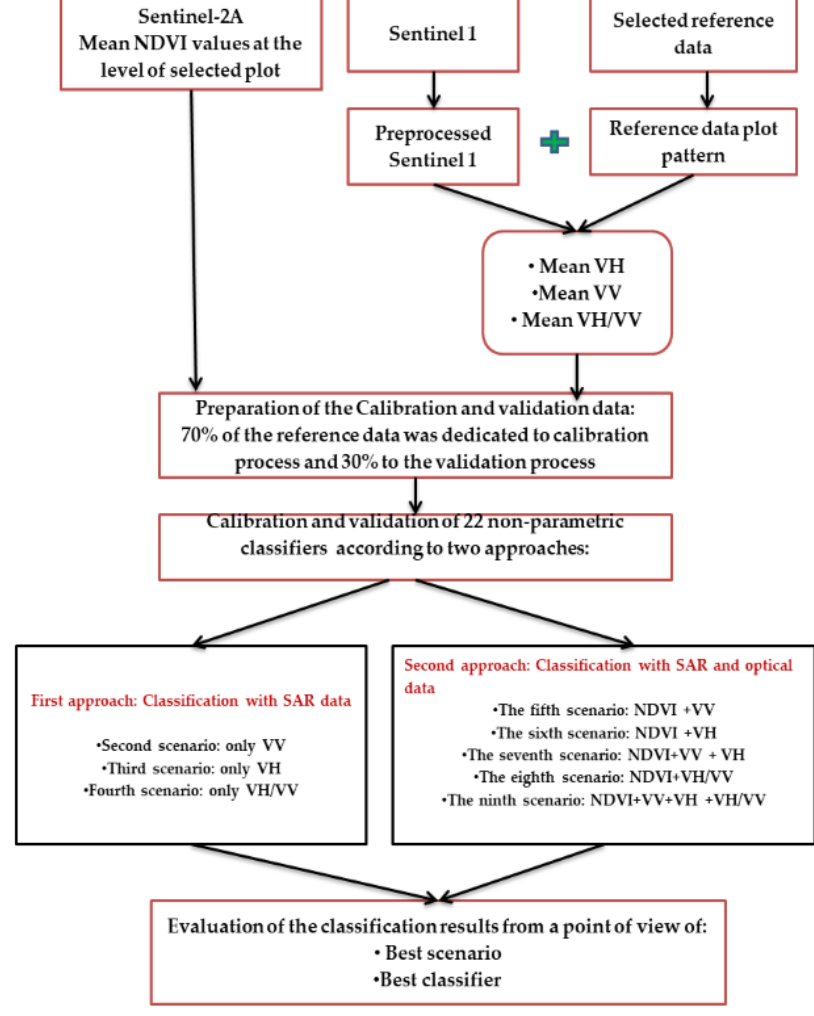
Figure 4. General workflow.